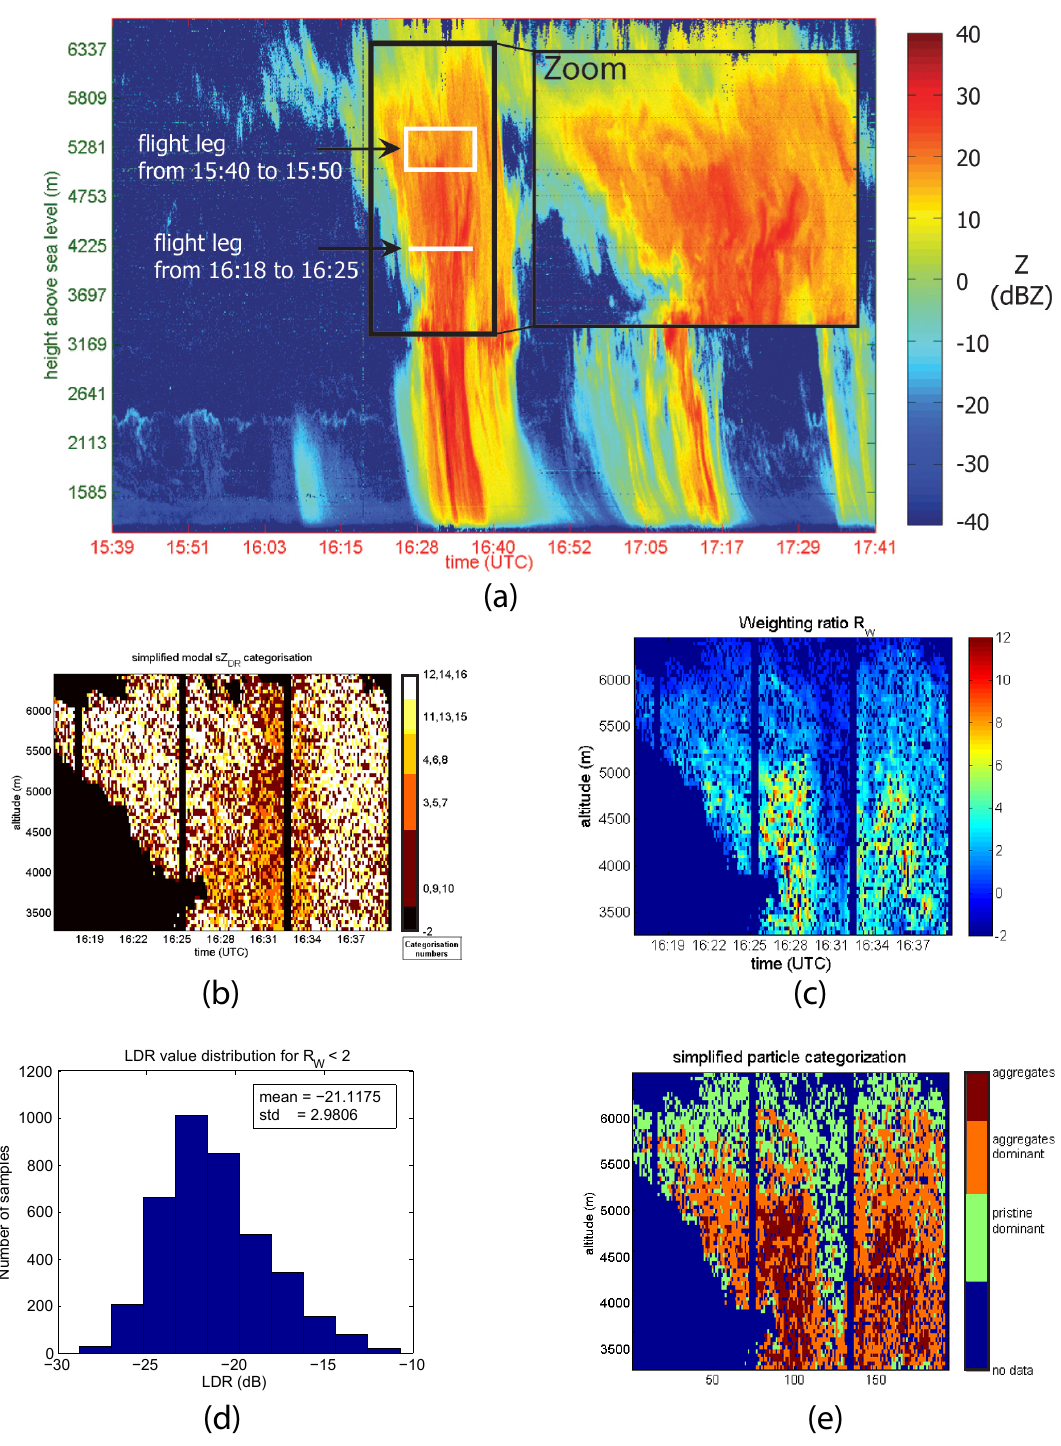
Fig. 11. Observations and retrievals obtained from the TARA measurements on 21 July 2007. (a) Reflectivity profile from TARA. The black box delimits the boundaries of the region where the retrieval technique is applied. The white box and white line represent the altitude of the flight legs performed by the ATR42 aircraft the same day. (b) Mapping of the sZ DR categorization results. (c) Mapping of the weighting ratio R w . (d) Histogram of L DR values when R w < 2. (e) Simplified particle type categorization obtained from (b) , (c) and (d)